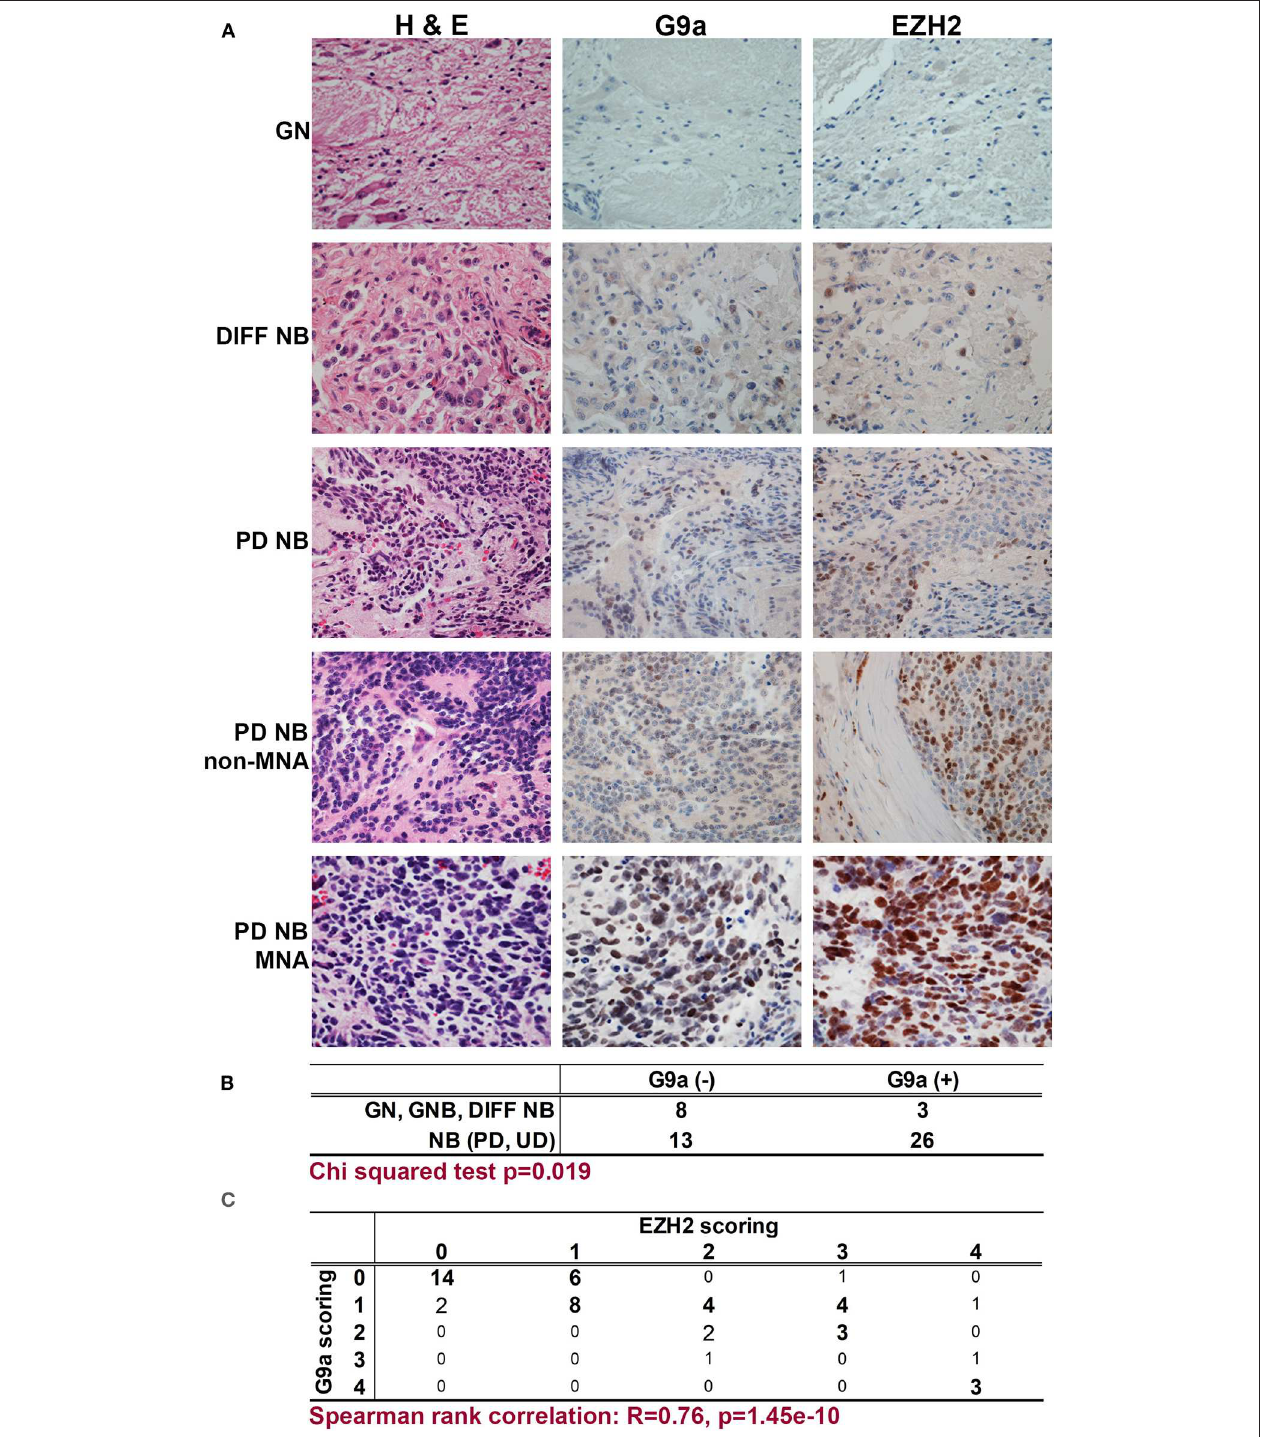
FIGURE 2 | Immunohistochemical detection of G9a and EZH2 in primary NBs. (A) Haematoxylin and Eosin staining, G9a and EZH2 immunohistochemistry of neuroblastic tumors. (GN, ganglioneuroma; DIFF NB, differentiating neuroblastoma; PD NB, poorly differentiated NB; UD NB, undifferentiated NB; MNA, MYCN amplified). (B) Positive staining for G9a correlates with INPC differentiation status of neuroblastic tumors. (C) Immunopositivity was scored based on the proportion of positive cells (0, no staining; 1, sporadic staining of individual cells; 2, < 20% of cells stained; 3, 20 to 80% of cells stained; 4, > 80% of cells stained). The proportion of G9a and EZH2 positive cells strongly and significantly correlated in neuroblastic tumors.